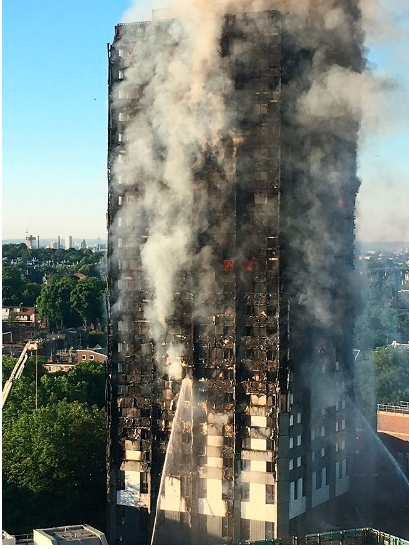
Figure 2. Image of the Grenfell Tower Fire. Photograph by Natalie Oxford, distributed under CC-BY license.